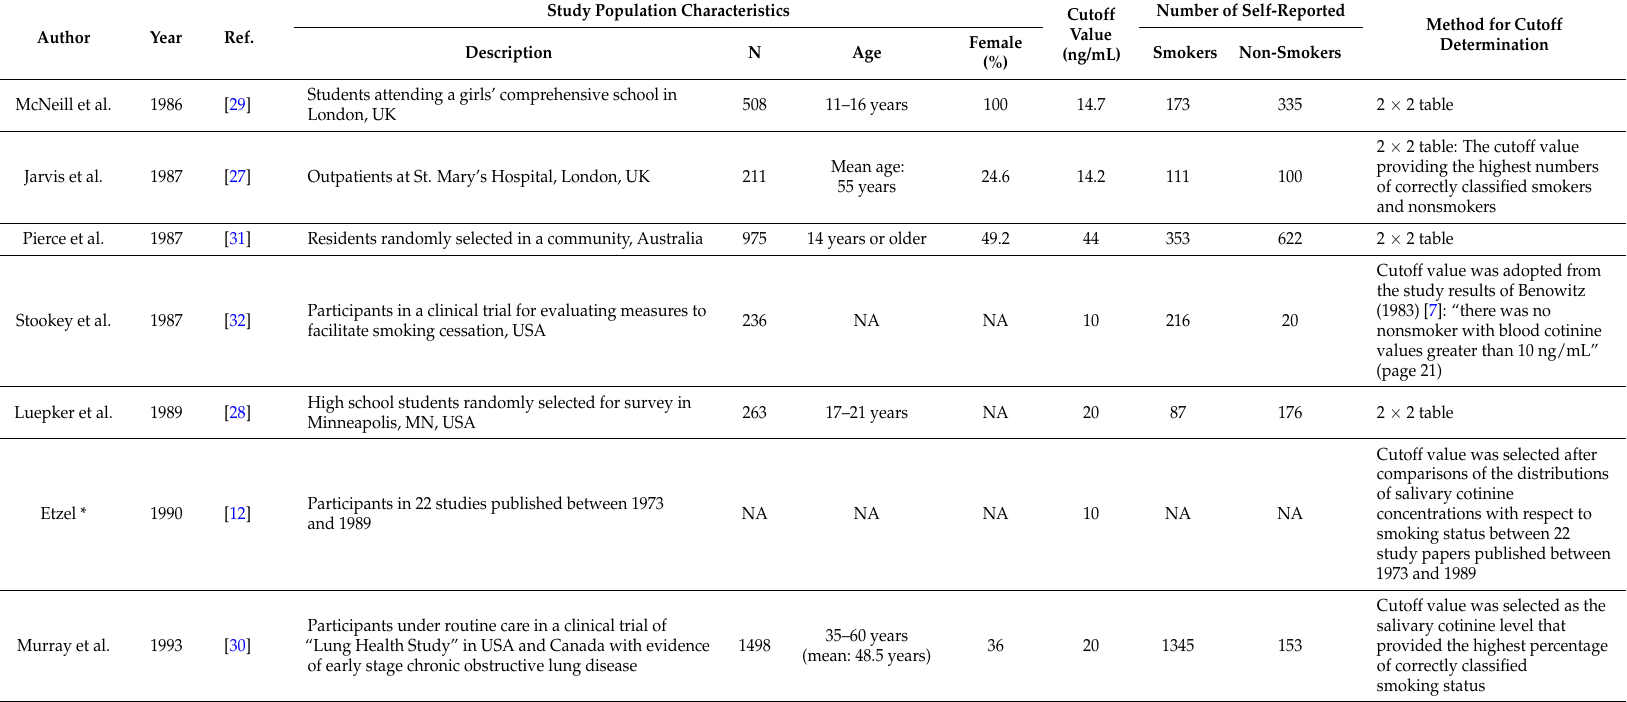
Table 1. Salivary cotinine cutoff values, and methods of cutoff determination.